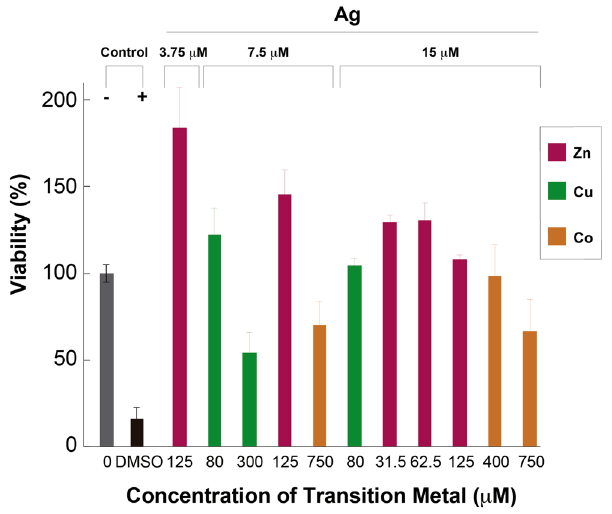
Figure 9. Cytotoxicity of STMCs on HaCat cells. Effect of STMCs on the viability of HaCat cells. Cells were treated with STMCs at different concentrations for 24 h and viability was determined. Data are expressed as percent of control mean ± SEM and analyzed by one-way ANOVA, with a Tukey post hoc test. ** p < 0.01 vs. control; N =